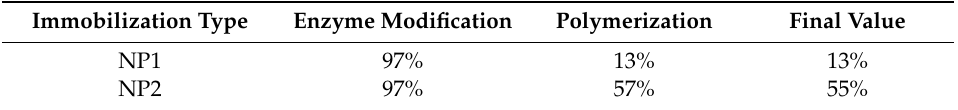
Table 1. Reduction of biocatalytic activity of α -chymotrypsin enzyme during synthesis steps of two di ff erent synthesis methods (initial enzyme activities were considered as 100% in both